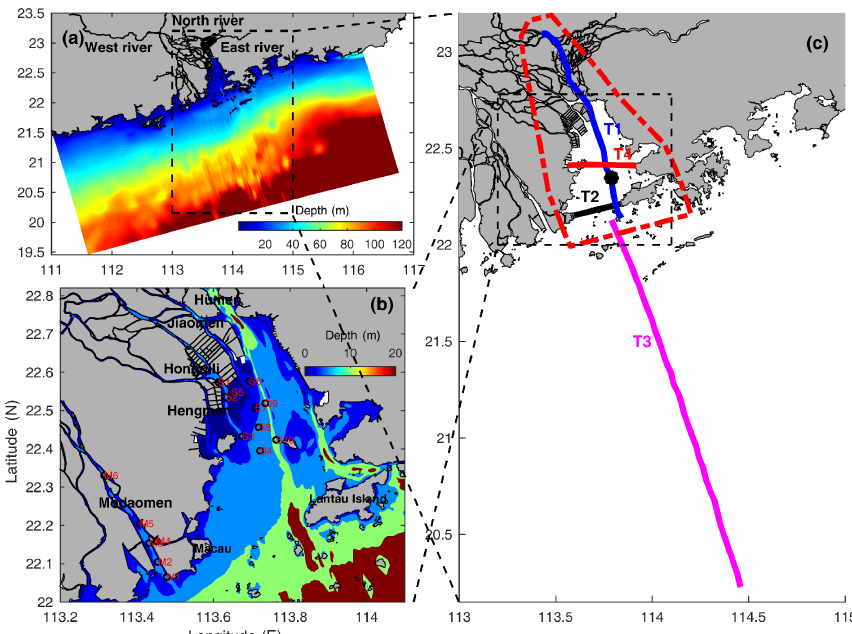
Figure 1. Major topographic features over the Pearl River Estuary and its adjacent waters, and the observation stations (symbols) and analysis transects. Panel (a) The study site and model domain. The West, North and East Rivers are three branches of the Pearl River, creating the Pearl River network in the Pearl River Delta (PRD). Panel (b) bathymetry of the PRE (in the right), the Modaomen estuary (in the lower-left), and locations of the measurement stations. The two green stripes in the PRE show the locations of the West and East Channels; adjacent to the two channels are the West, Middle, and East Shoals. Panel (c) sections and station for analysis. The red dash box is the region of the PRE. T1 is the longitudinal transect along the West Channel and the upstream tidal river; T2 is the cross section at the estuary mouth; T3 is the cross-section on the continental shelf; T4 is the cross-section in the middle of the estuary; the black dot is the station for analysis in the